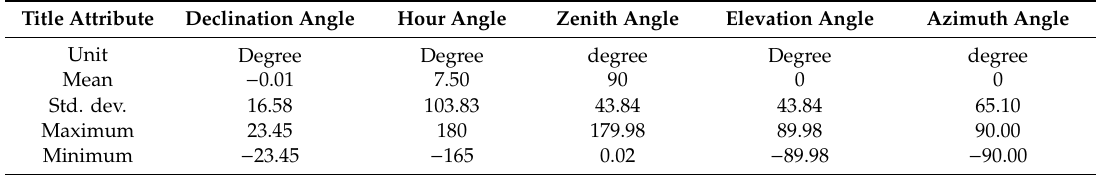
Table 3. Solar position attributes and statistics at the Tainan